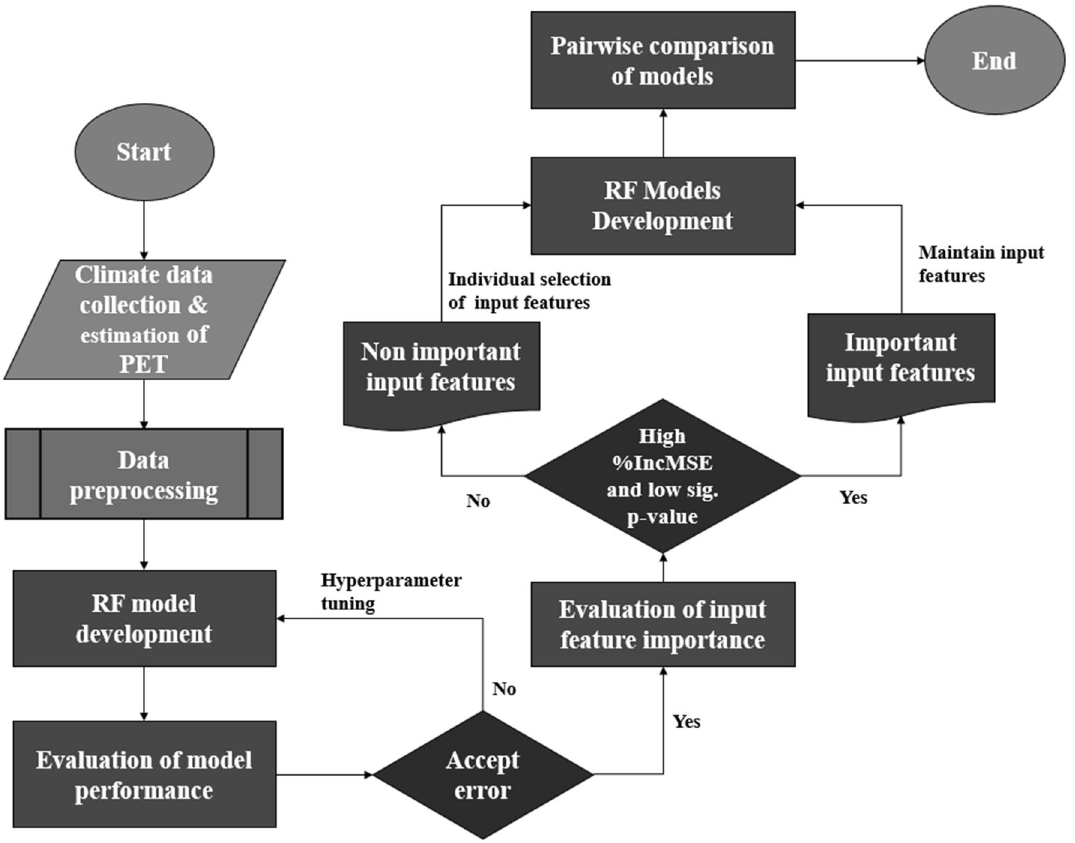
Fig. 3 General methodological